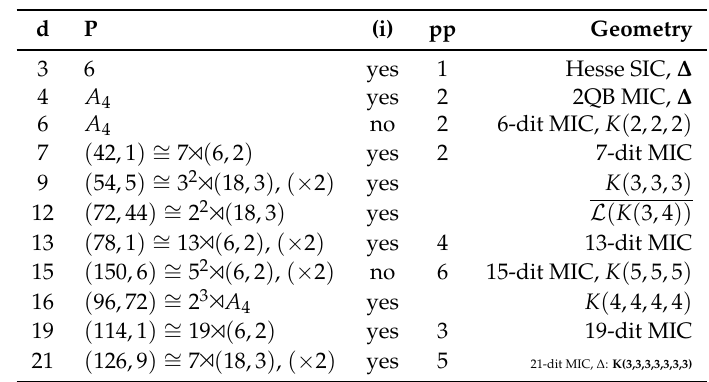
Table 3. Table of subgroups of the fundamental group π 1 [ S 3 the trefoil knot, when the condition (i) is satisfied or when a MIC is missed. See the captions of Tables 1 and 2 for the meaning of abbreviations.